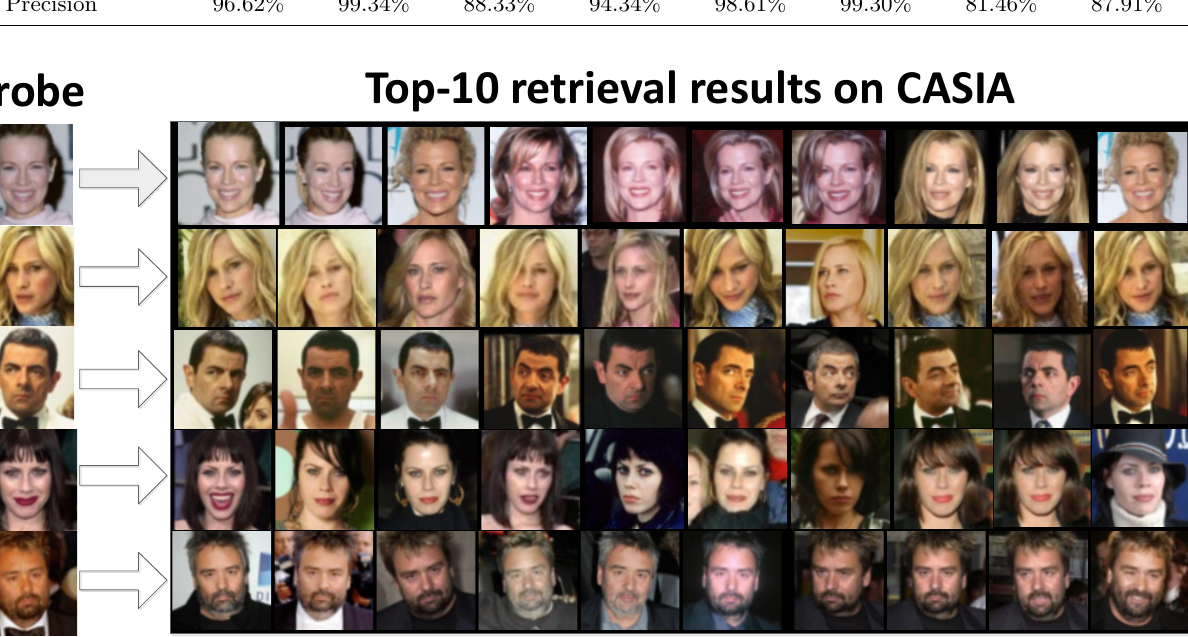
Fig. 6 Top-10 retrieval results for five probes using